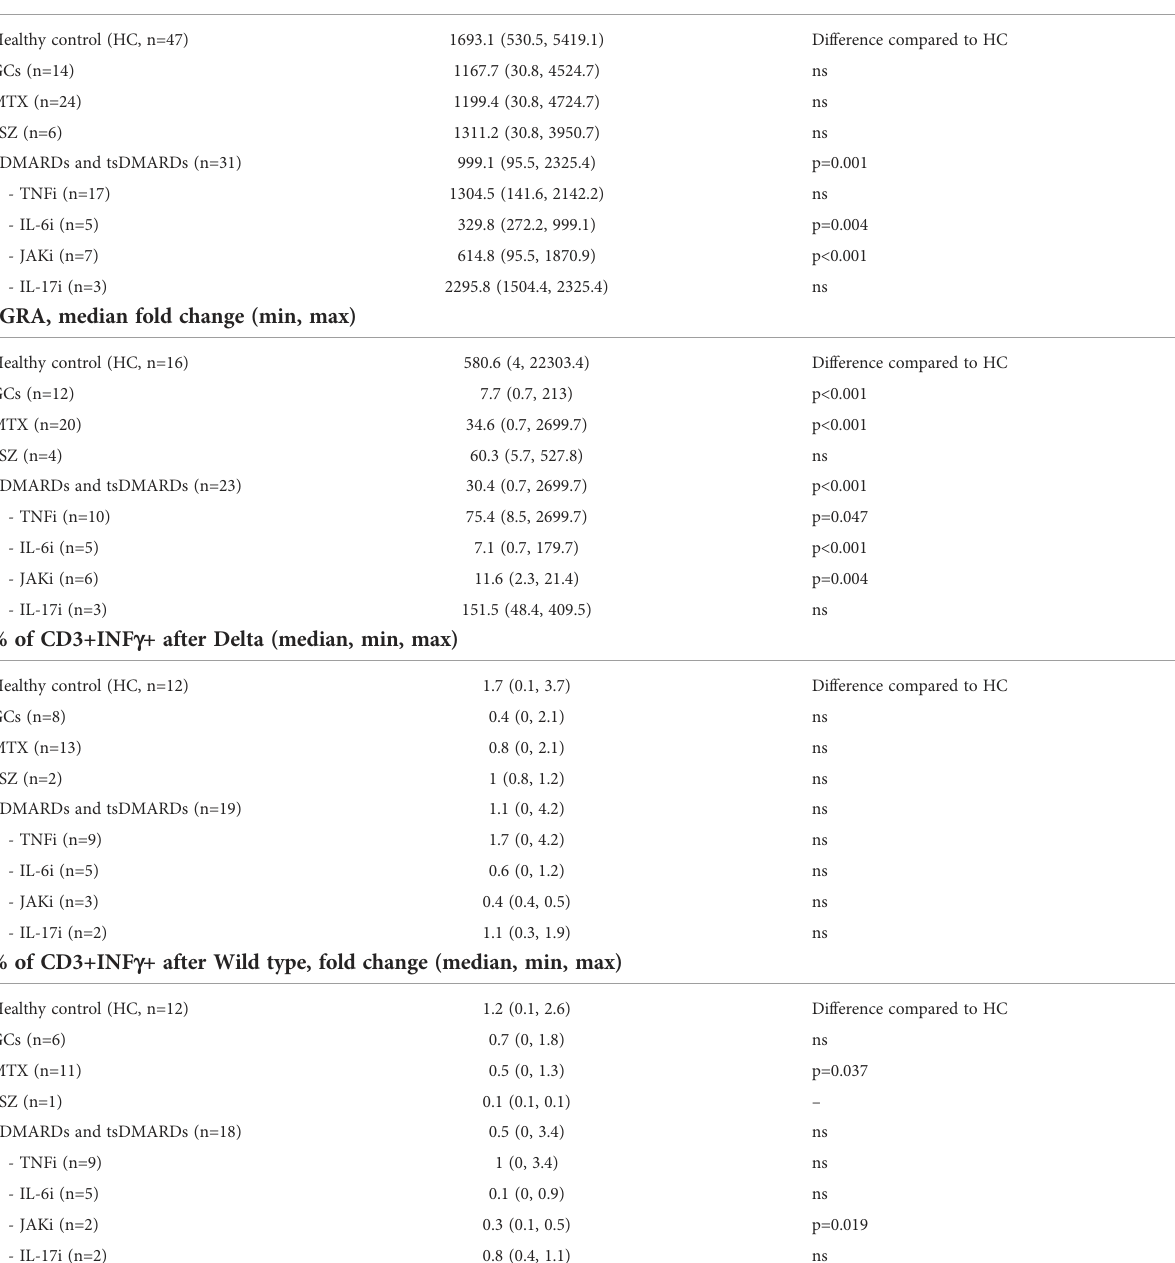
TABLE 3B Effect of immunomodulating drugs on the immunogenicity of the COVID-19 vaccines after 4 weeks from booster dose. IgG antibodies, median RU/ml (min,